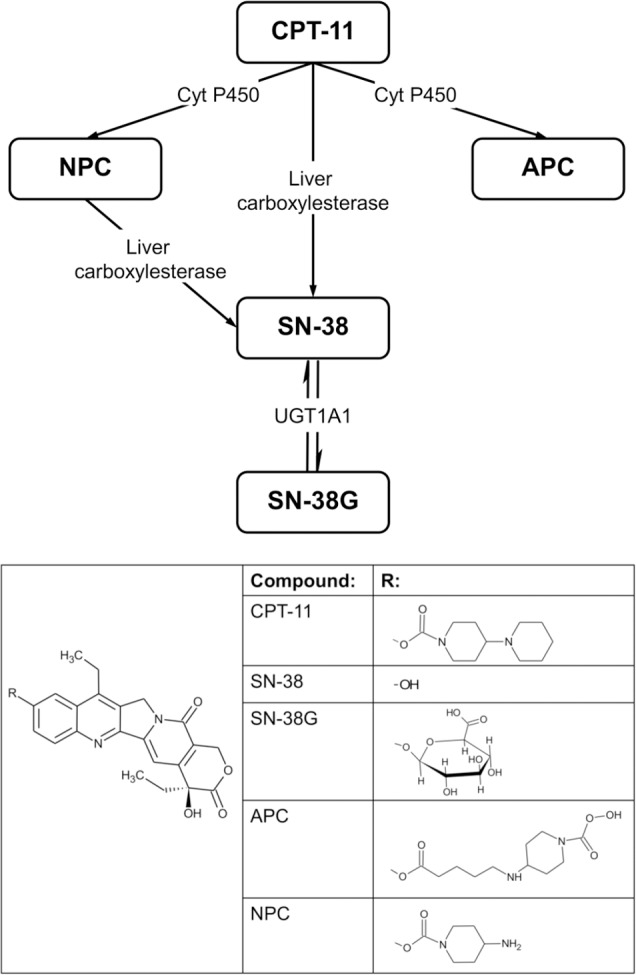
Metabolic pathway and structures of CPT-11 and its main metabolites: SN-38, SN-38G, APC and NPC.Cyt P450: cytochrome P450; UGT1A1: UDP-glucoronosyltransferase 1A1.